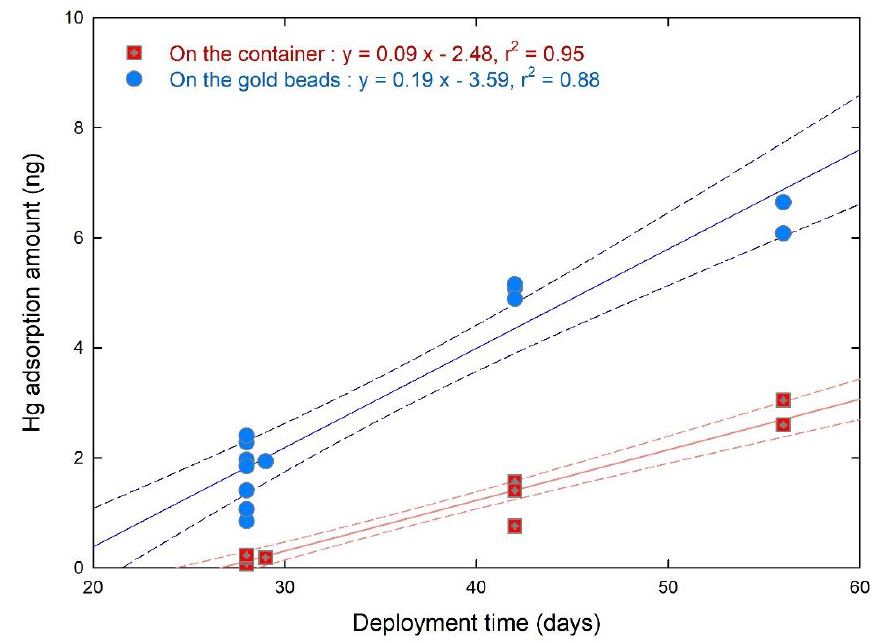
Figure 5. Change in Hg adsorption on the gold-coated beads (blue circles) and the stainless-steel container (red squares) with an increase in deployment time. The short-dashed lines indicate 95% confidence intervals.